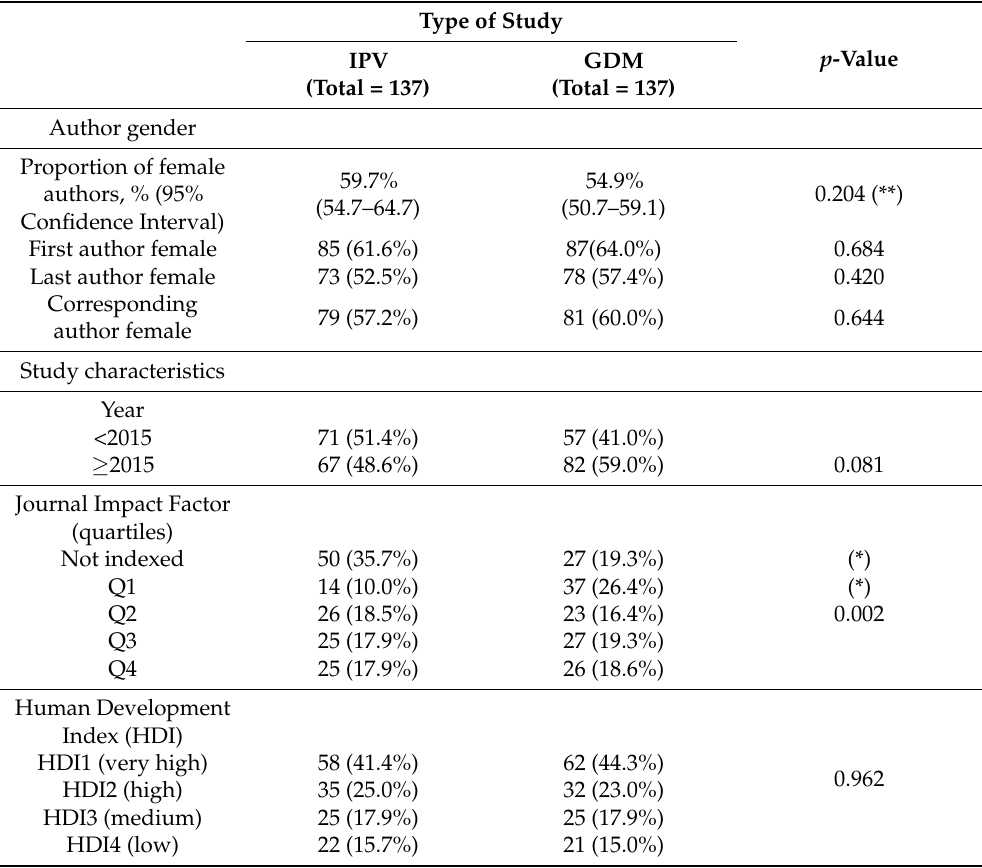
Table 1. Characteristics of intimate partner violence (IPV) during pregnancy and gestational diabe- tes mellitus (GDM) prevalence studies included in the author gender study.